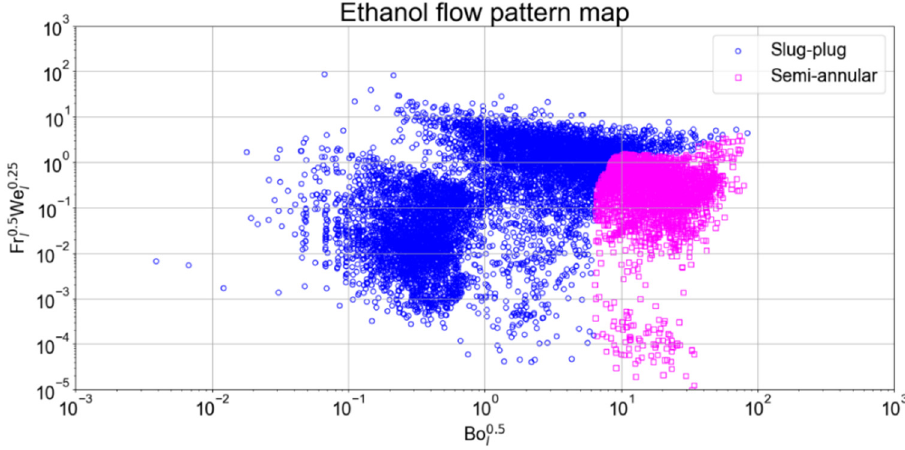
Figure 7. Flow pattern map for ethanol: multilayer perceptron.